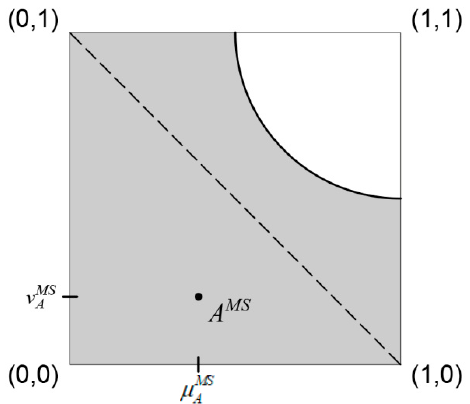
Figure 5. Interpretational surface of GIFS-MS with product as t -norm.